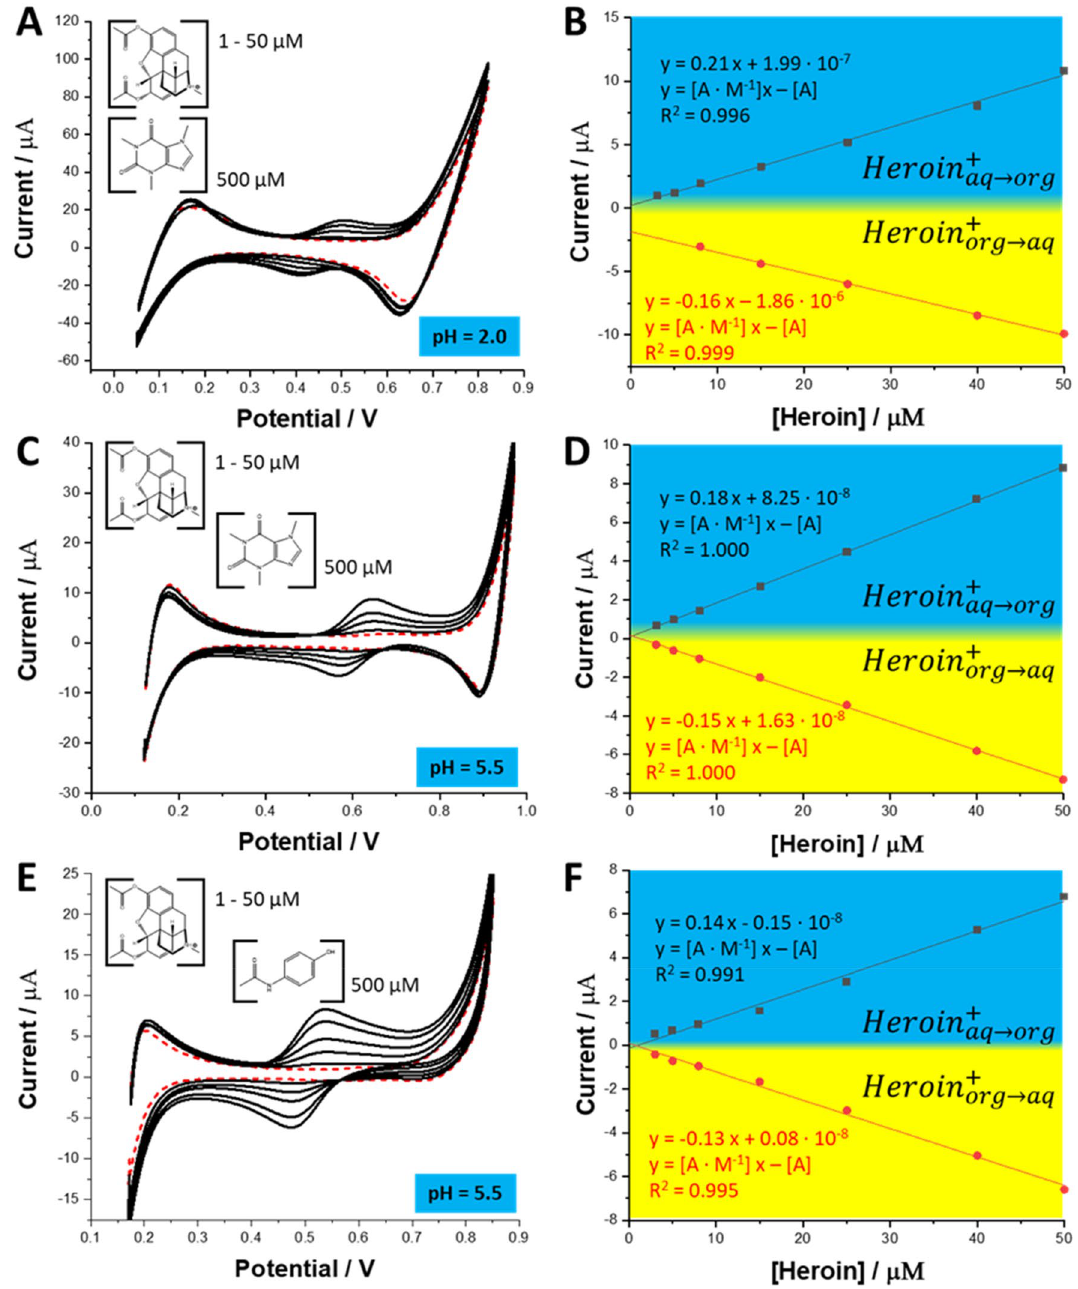
Figure 3. CVs recorded for the increasing concentration of heroin (from 1 to 50 µM) in the presence of ( A ) – 500 µM caffeine at pH = 2.0; ( C ) – 500 µM caffeine at pH = 5.5; and ( E ) – 500 µM paracetamol at pH = 5.5. The scan rate was 20 mV·s −1 . ( B ), ( D ) and ( F ) are the calibration curves plotted based on the positive and negative peak currants prepared base on CVs from sections ( A ), ( C ) and ( E ),